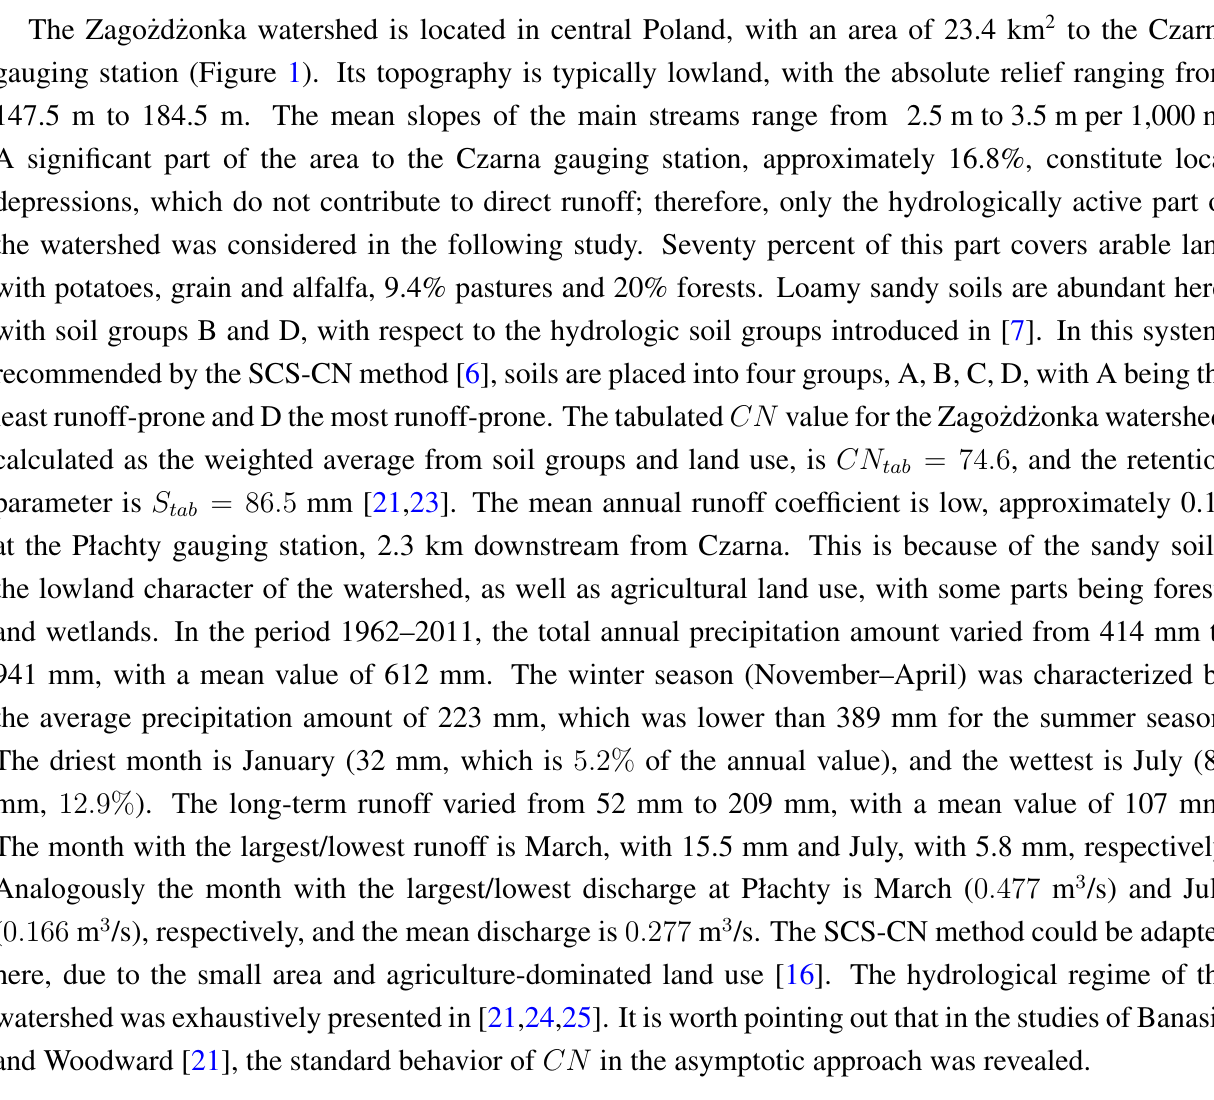
Figure 1. The Zago ˙ zd ˙ zonka watershed with the Czarna gauging station,